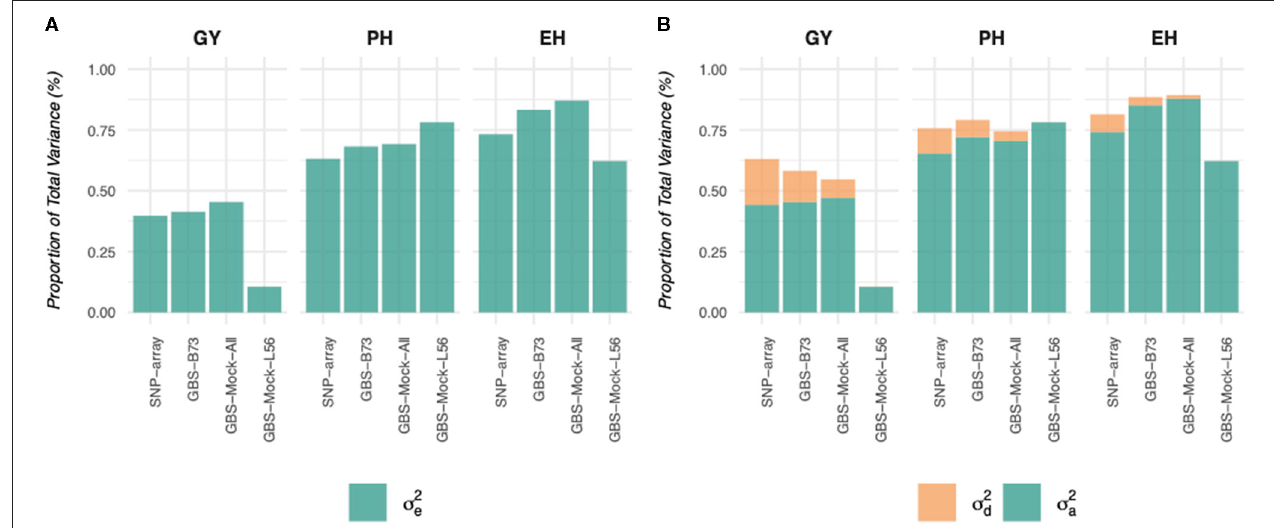
FIGURE 2 | Proportion of the phenotypic variance explained by the estimated components of variance in the different traits (EH, ear height; PH, plant height; GY, grain yield), models and scenarios studied.